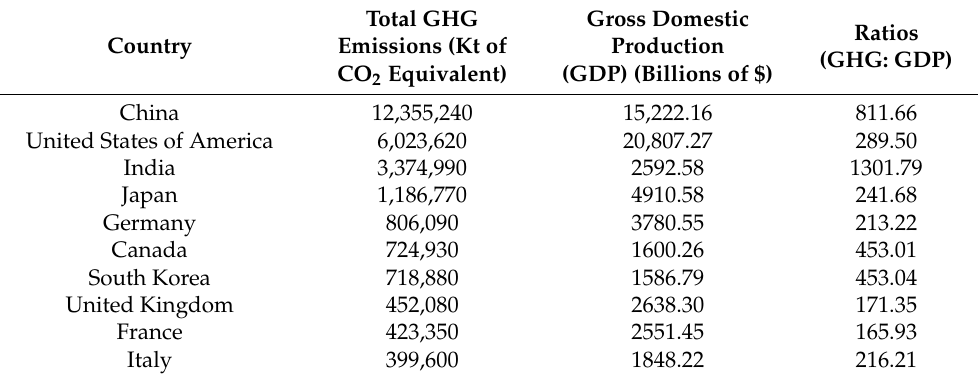
Table 1. Country-wise total greenhouse emissions and gross domestic production. Country